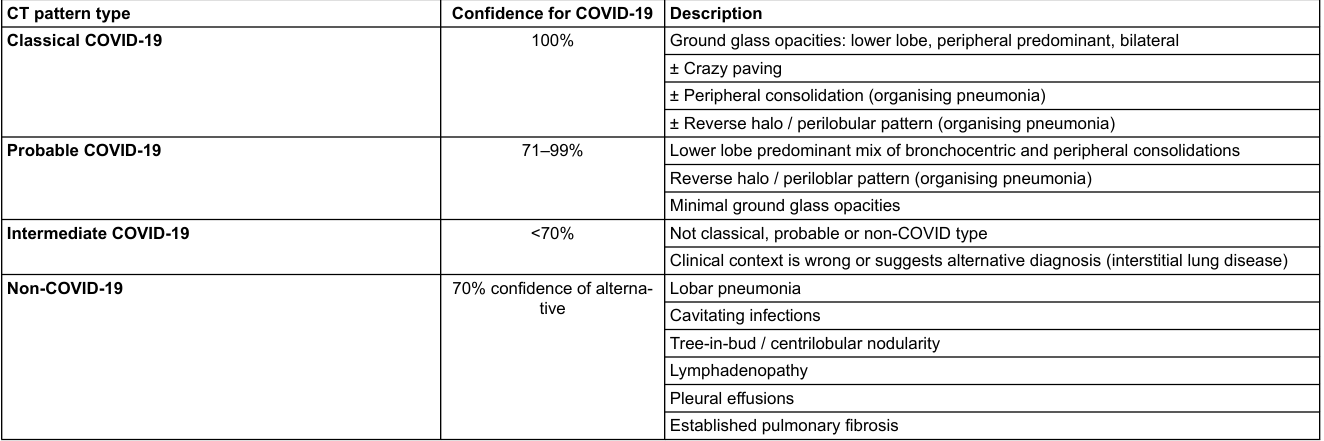
Table 3: Chest computed tomography (CT) imaging patterns typical and atypical for COVID-19 pulmonary infections. CT pattern